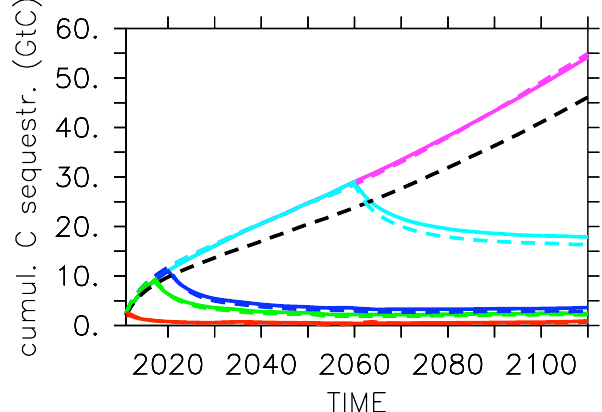
Fig. 13. Solid lines: Cumulative temporal integral of the fertilization-induced reduction in atmospheric CO 2 for the different OIF runs. The dashed black line is for emission reductions 1.0 times the air-sea CO 2 flux of the continuous iron fertilization run. Dashed colored lines: Cumulative temporal integral of the reduction in at- mospheric CO 2 achieved by emission reduction 1.2 times the global air-sea CO 2 flux of the respective OIF run. Units are GtC. Colour code as in Fig.